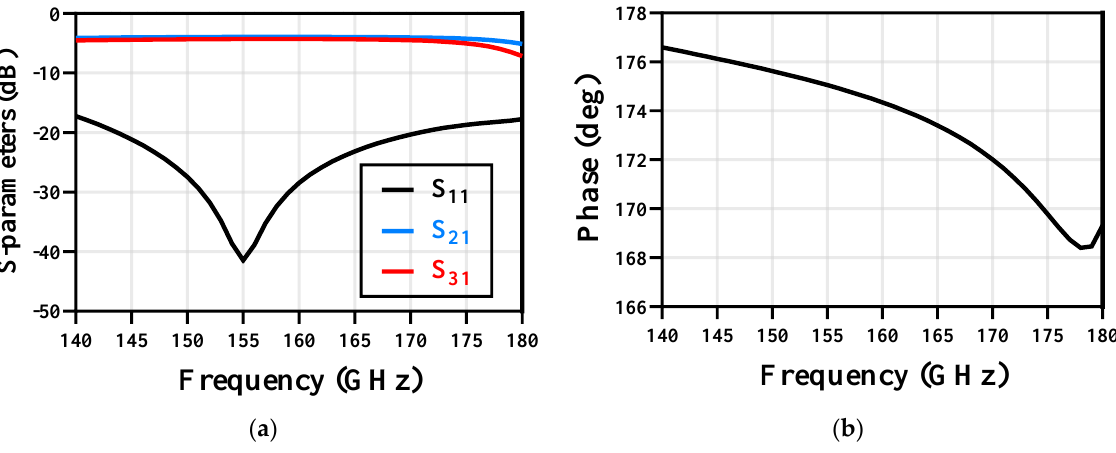
Figure 9. The 3D structure of the proposed Marchand balun.